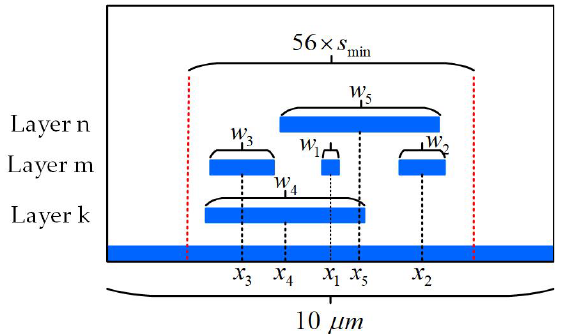
Figure 10. The illustration of extraction window width and the solving domain width.